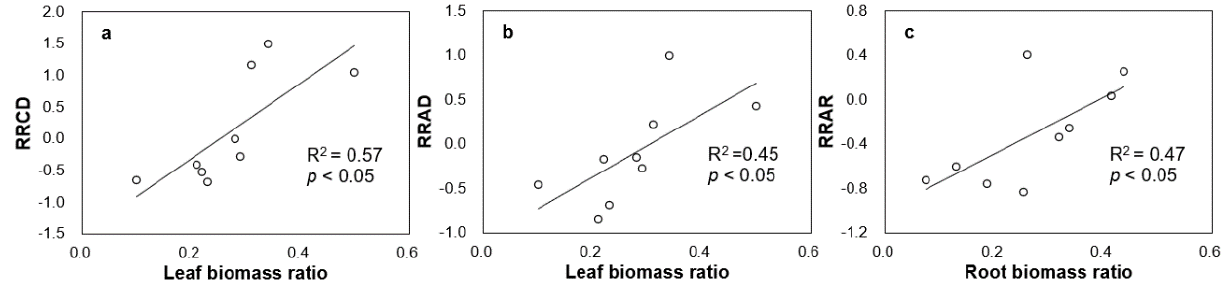
Figure 5. Relationships of changes of cover with leaf biomass ratio ( a ); changes of abundance with leaf biomass ratio ( b ) under the drought; and changes of abundance with root biomass ratio ( c ). Abbreviations as Figure 4.